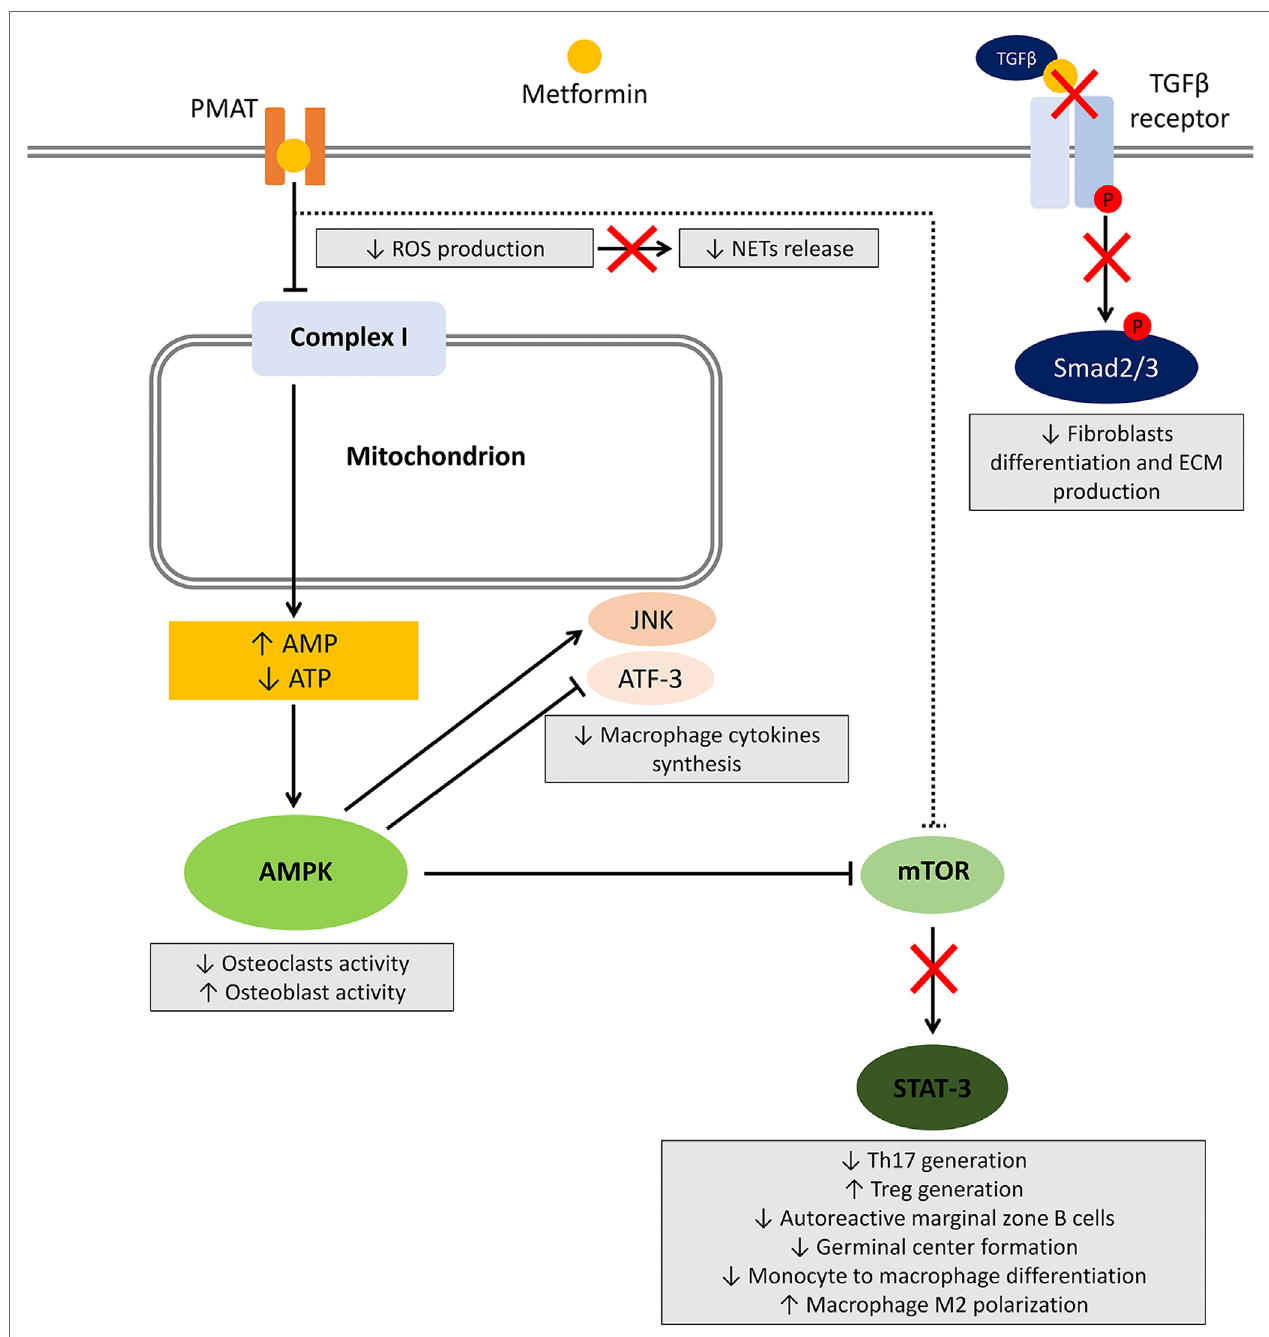
FigURe 1 | Effects of metformin on immune cells. After entering the cell, metformin transiently inhibits NADH:ubiquinone oxidoreductase (complex I) located in the inner mitochondrial membrane leading to a reduced ATP production and increased AMP:ATP ratio. The resultant metabolic shift stimulates the activation of the energy sensor 5 ʹ -AMP-activated protein kinase (AMPK). Among several targets, AMPK activation inhibits mammalian target of rapamycin (mTOR), responsible for most of the effects on the immune system. Other potential mechanisms include AMPK-independent inhibition of mTOR, reduced reactive oxygen species (ROS) production, and block of the TGF- β receptor/Smad interplay. The effects on immune cells are summarized in gray boxes.